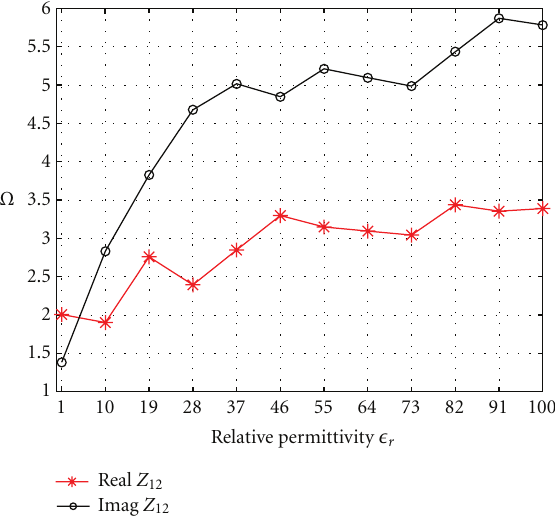
Figure 5: Mutual coupling between two λ/ 4 monopoles at 2.4GHz for (cid:2) r = 1 to 100, σ = 0 . 02